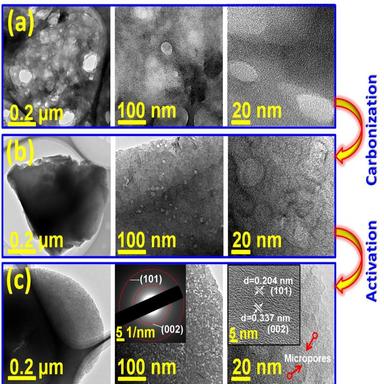
HR-TEM images at different magnifications of (a) Jujube fruit powder, (b) JC and (c) JPC.